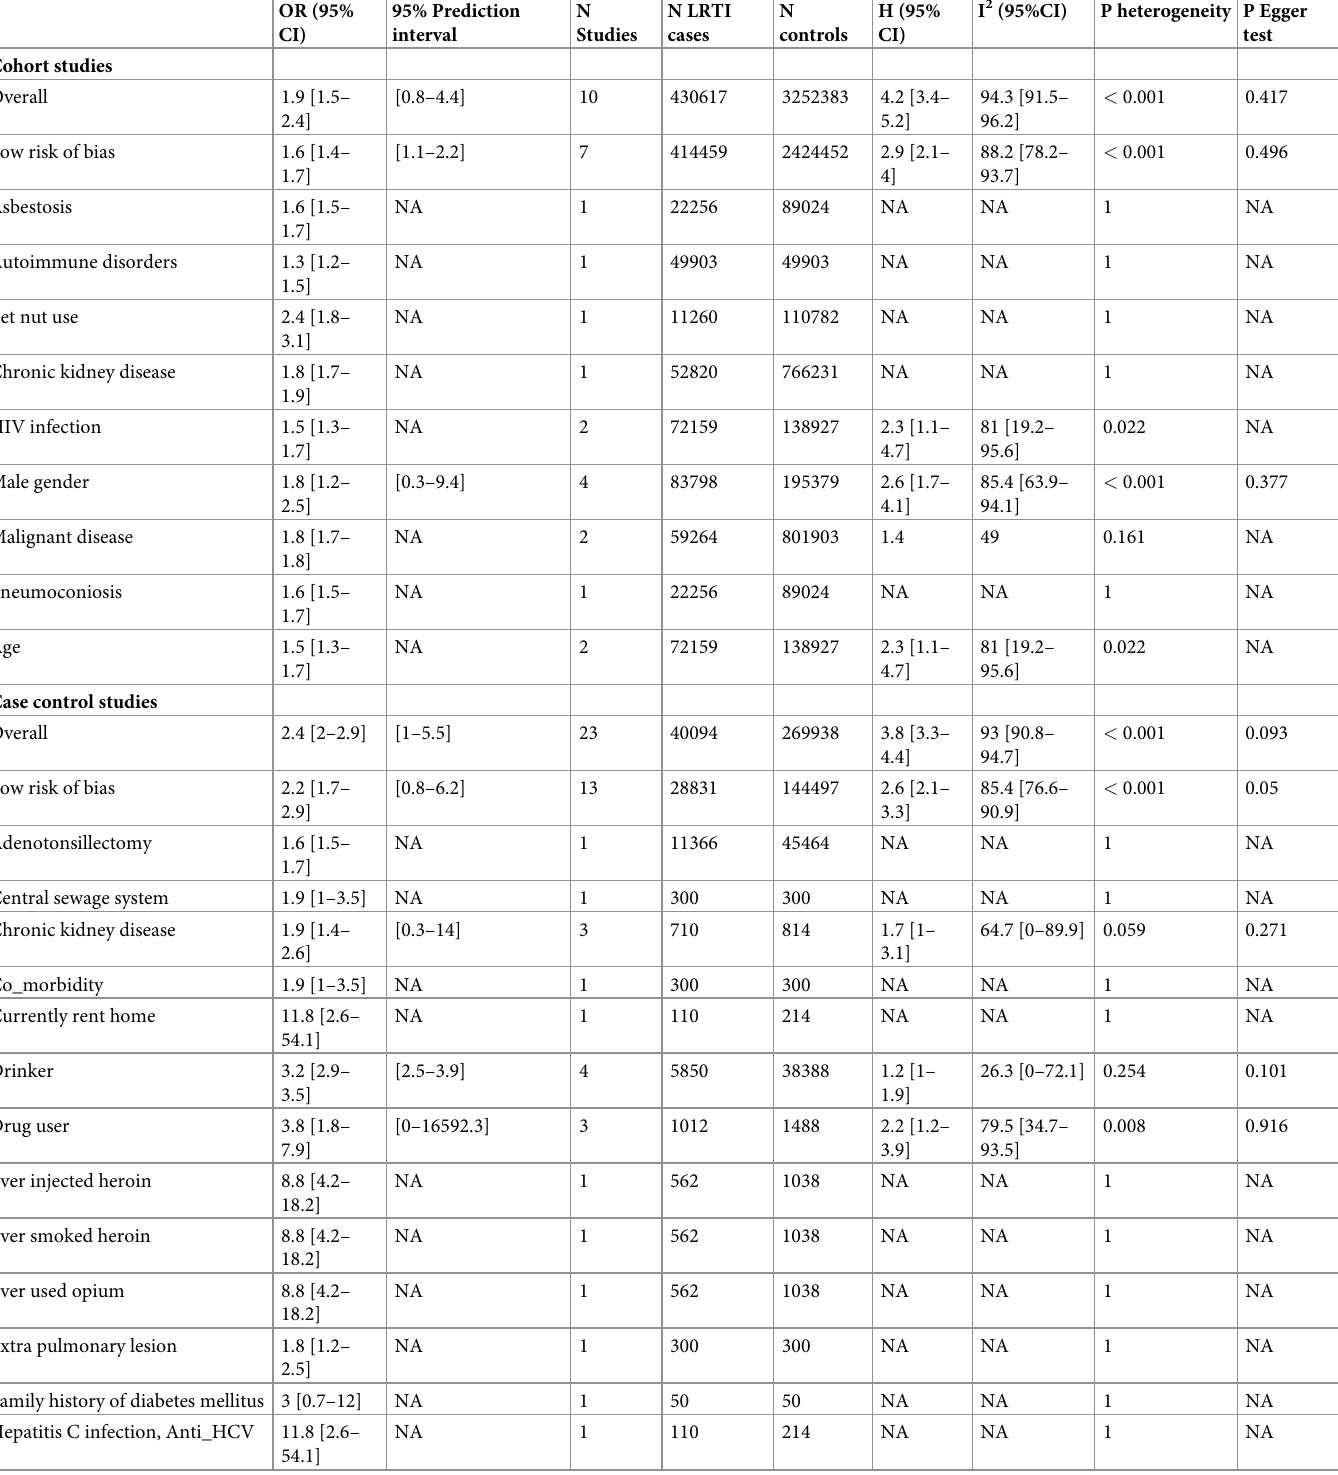
Table 2. TB development in people with and without DM and influence of